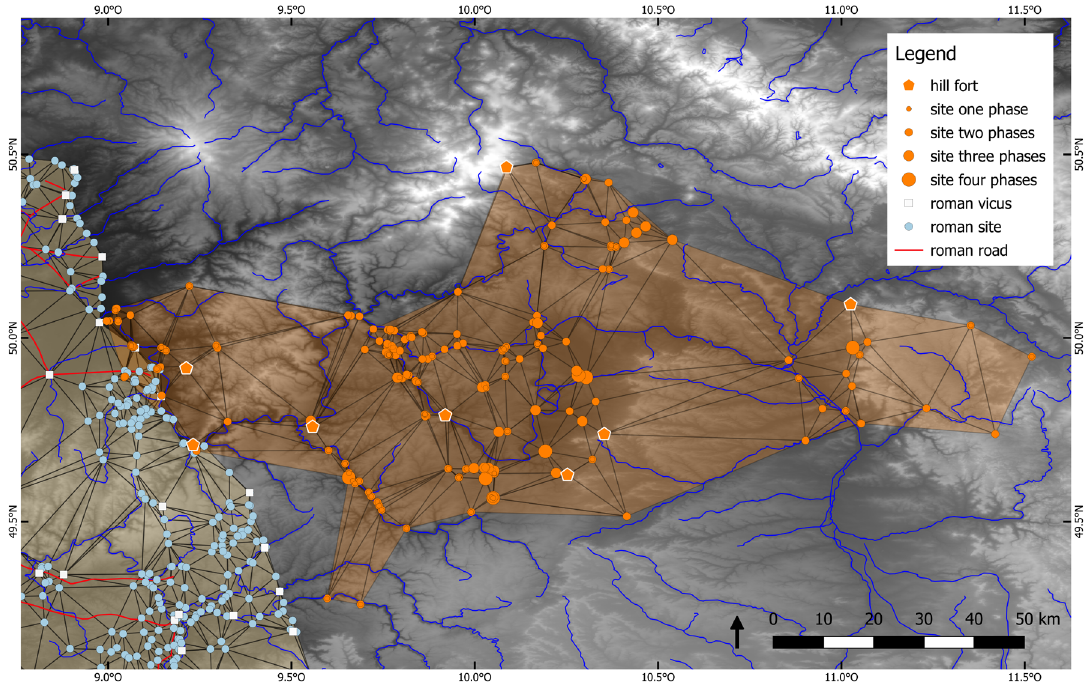
Figure 10. Sites dating to the Early Migration Period (Eggers Phase D, 380-480 AD). Some sites in the central settlement cluster date to three or four periods of the Roman Iron Age and the Early Migration Period. These were often in continuous use as settlements or cemeteries since the Late Roman Iron Age. Some cemeteries and settlements were abandoned. During the Early Migration Period fortifications, in the form of hill forts from the pre-Roman Iron Age, are re-utilized. That is the reason why the hill forts are not in the centers of the settlement sub-clusters. Sources: see Fig. 3, GIS